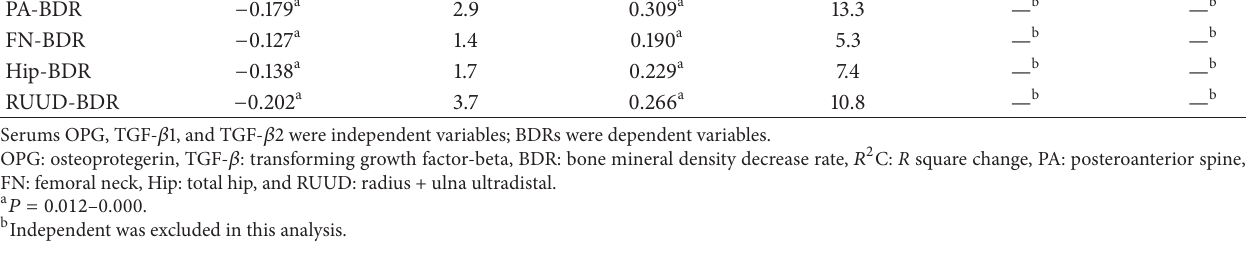
Table 4: Multiple linear regression analysis of OPG, TGF- 𝛽 1, and TGF- 𝛽 2 with BDR at various skeletal sites in native Chinese women.